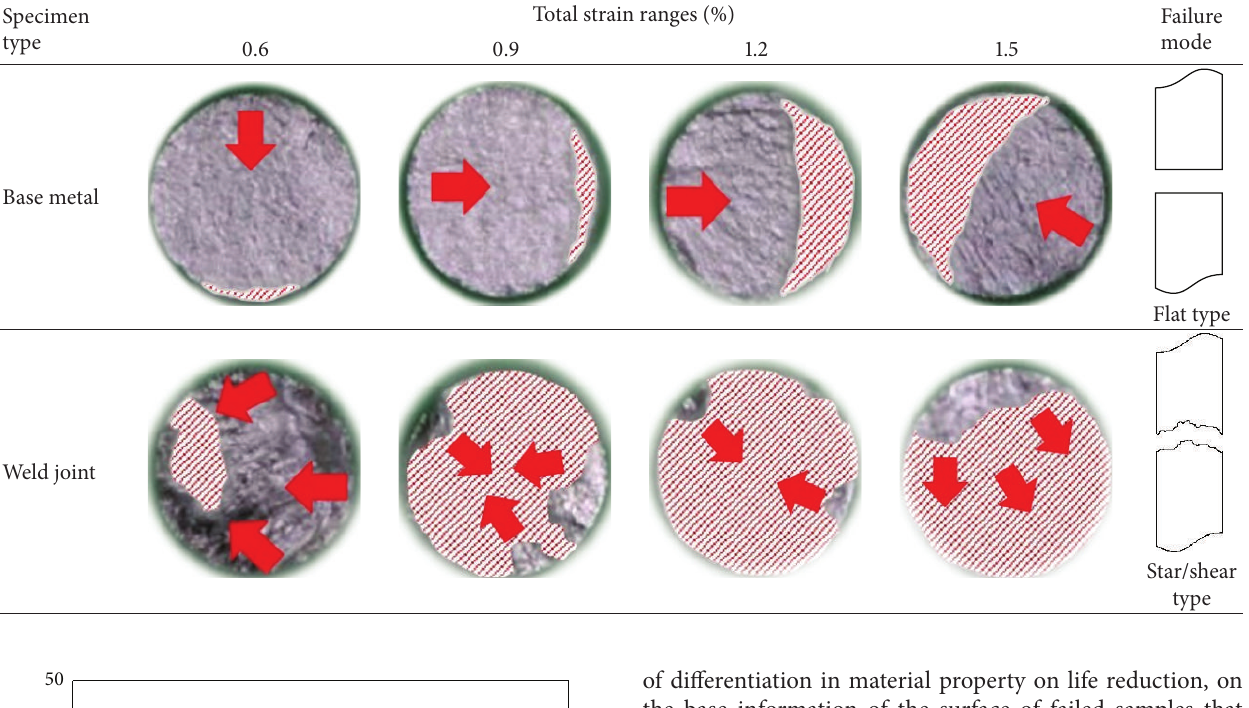
Table 5: The schematic diagrams of failure pattern for Alloy 617 BM and Alloy 617 WJ tested at RT.